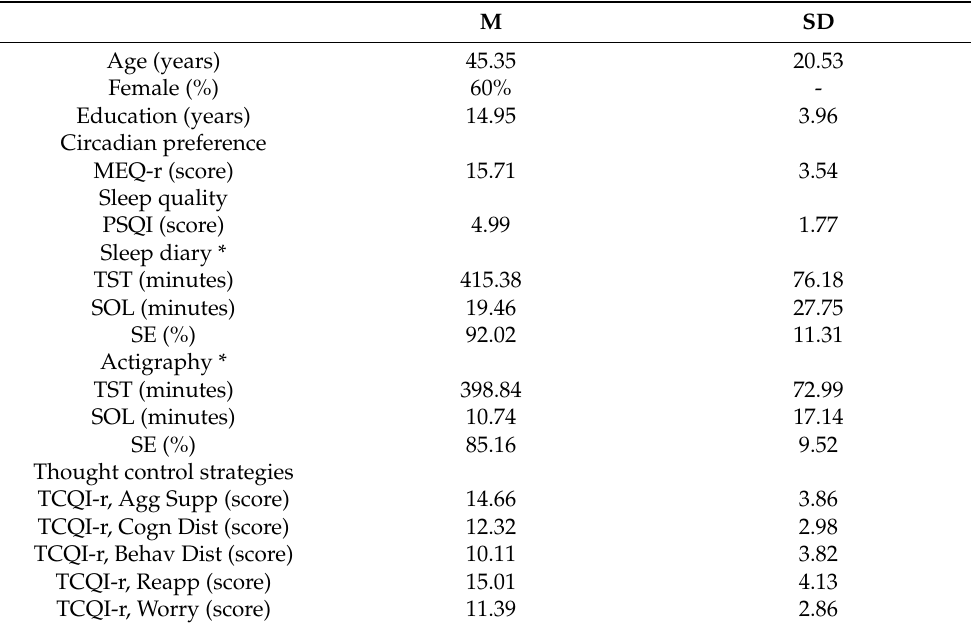
Table 1. Mean (M) and standard deviations (SD) of the sample’s demographic characteristics and the measures of